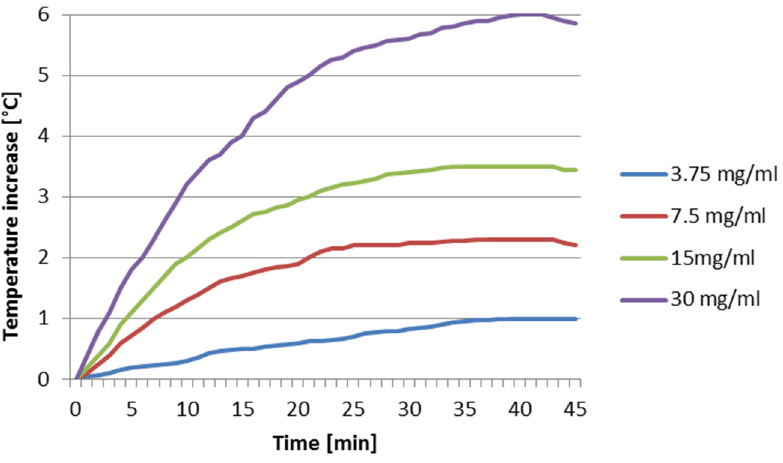
Figure 6. Plots of temperature change in time of samples 9–12 in frequency 329 kHz.